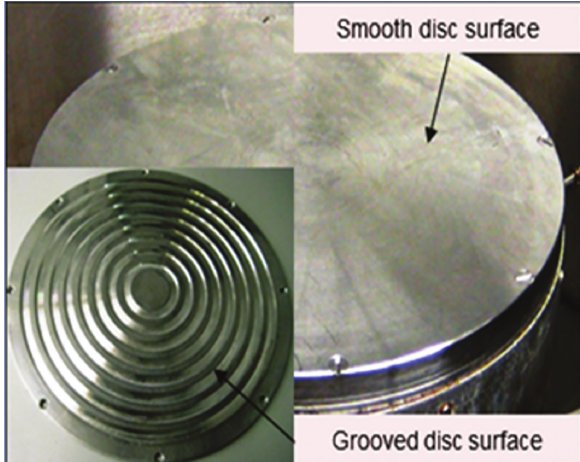
Figure 2: The grooved and smooth disc surfaces used in SDR experiments.